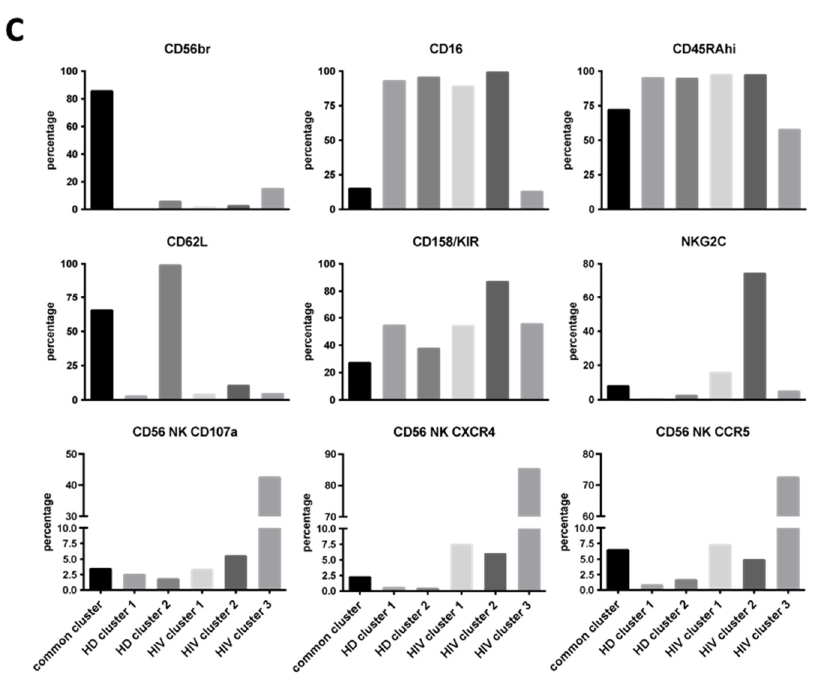
Figure 7. Cluster analysis on CD56 + NK cells by tSNE mapping in viremic patients. The tSNE map was built from 40,000 pre-gated CD56 + NK per sample (HD: n = 4, HIV-1: n = 4) based on 12 surface markers (supplementary Figure S5). ( A ) General tSNE map from all samples (left), HD samples (middle) and HIV-1 + samples (right) with identification of group-specific clusters. ( B ) tSNE replica showing clusters of each viremic HIV-1 patient. ( C ) Phenotypical characters of each cluster as identified in ( A ). Bar graphs represent the proportion of positive cells for each of the surface markers from the whole of events analyzed in each cluster.